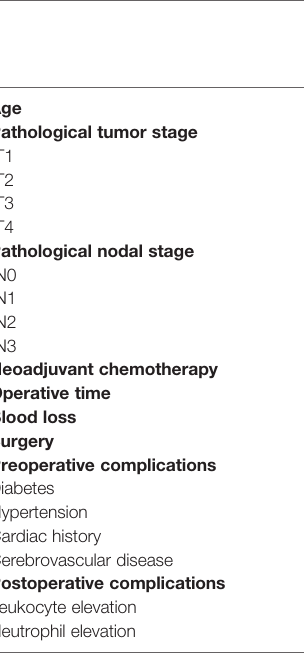
TABLE 3 | OR for increasing of D-dimer — multivariable analysis (n =